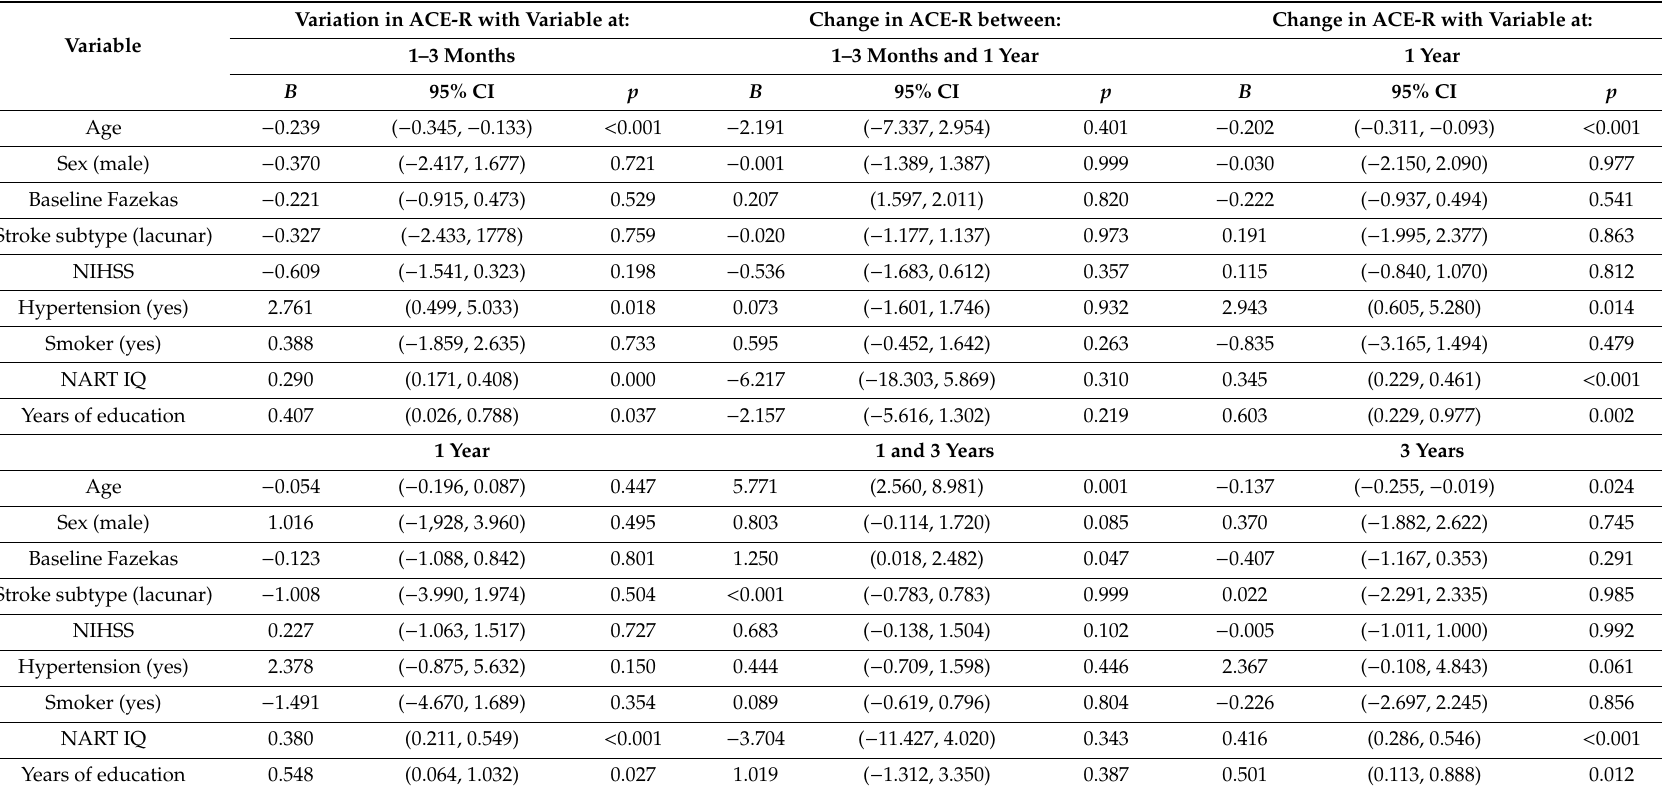
Table 5. Linear mixed e ff ects models showing factors associated with changes in current ACE-R scores at each time point.